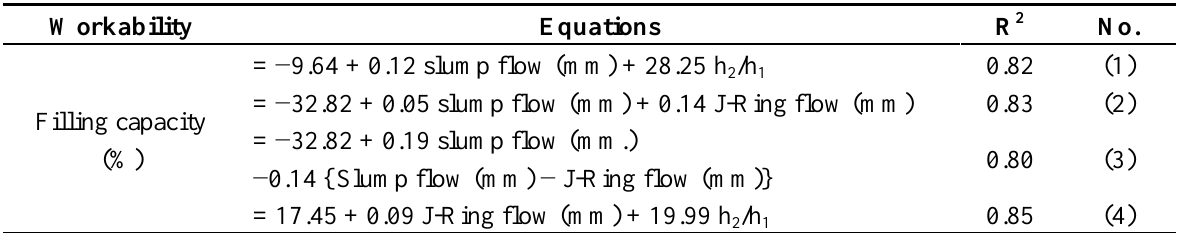
Table 5. Multi-regression equations.